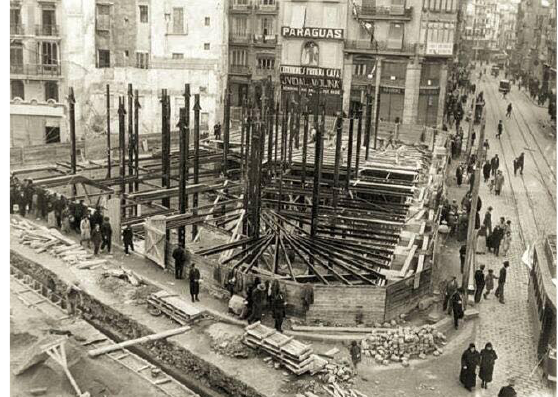
Figure 15. Building at 16 San Vicente Street, 1921-1931.